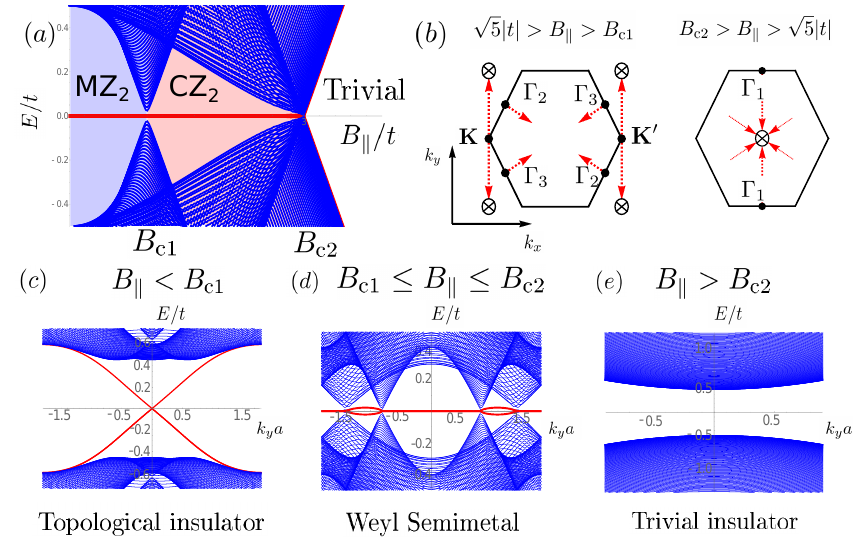
Figure 2: (Color online) In panel (a), we show the energy spectrum as a function = 0. Here, blue (red) color depicts bulk (edge) of B (cid:107) for an AC nanoribbon at k y = | t | , MZ states. For B (cid:107) < B is the topological invariant, while for the range c 1 2 ≥ B ≥ B 3 | t | = B , CZ is the topological invariant. In panel (b) we show the (cid:107) c 2 c 1 2 creation (black dots) and annhilation (cross) of the Weyl points in reciprocal space for the KM model. In panels (c)-(e), we show the energy spectrum as a function of k for three different magnetic fields, corresponding to the three different phases from panel (a): Topological insulator, topological semimetal and trivial